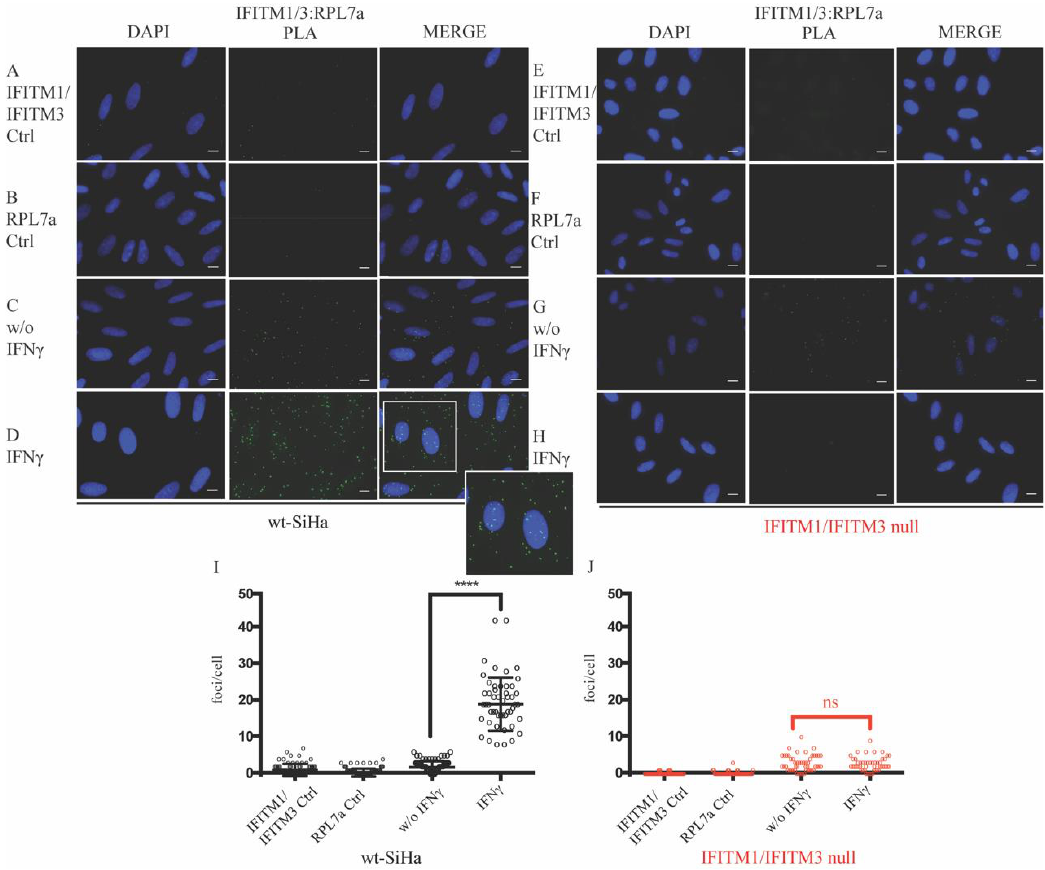
Figure 4. Evaluation of the IFITM1/IFITM3:RPL7a protein–protein expression and interaction in situ after stimulation with IFN γ . Proximity ligation assays were used to study the endogenous interaction between RPL7a and IFITM1/IFITM3 proteins in wt-SiHa ( A – D ) and IFITM1/IFITM3 null cells ( E – H ). IFITM1/3:RPL7a PLA images identify the protein–protein association foci (green) and DAPI was used for nuclear staining (blue). ( A , B and E , F ) Cells were incubated as negative controls using IFITM1/IFITM3 or RPL7a antibodies only. ( C , G ) Cells were incubated with both IFITM1/IFITM3 and RPL7a antibodies to define protein–protein foci in nonstimulated cells. ( D , H ) Cells were incubated with both IFITM1 and RPL7a antibodies to define protein–protein foci in IFN-stimulated cells. Magnification of selected area at the bottom right of merge ( D ). Representative quantification of the protein–protein interaction foci per cell in presence or absence of IFN stimulation in wt-SiHa ( I ) and IFITM1/IFITM3 null ( J ). At least 50 cells were counted for each condition. Statistical study was performed with one-way ANOVA and Bonferroni correction (**** p < 0.0001; ns, not significant). n = 3. Scale bar: 10 µ